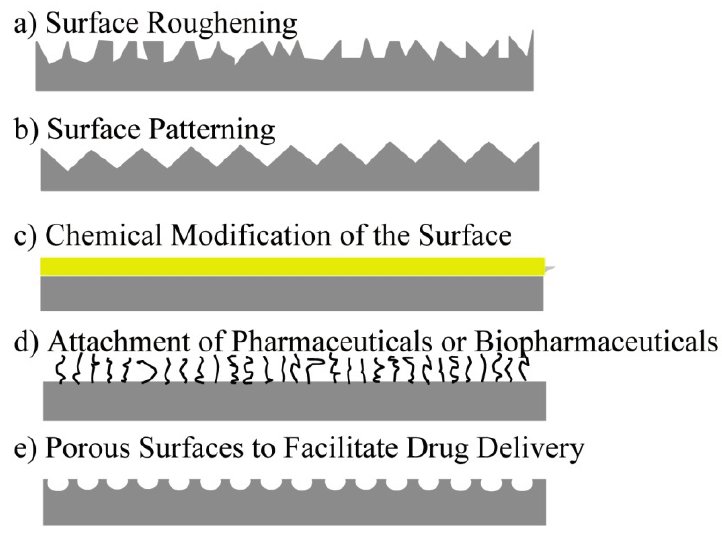
Figure 1. Surface modification techniques commonly used to enhance endothelialization and/or reduce